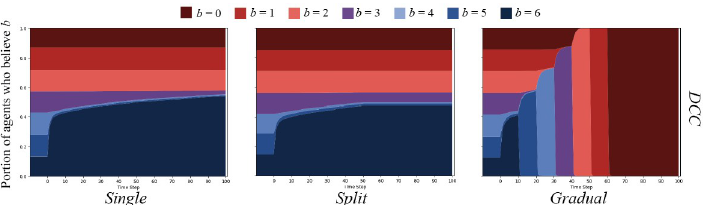
Fig 9. DCC results on BA preferential attachment networks. DCC on a Baraba´si-Albert preferential attachment network with N = 500, and added edges m = 3. Graphs show the percent of agents who believe B with strength b over